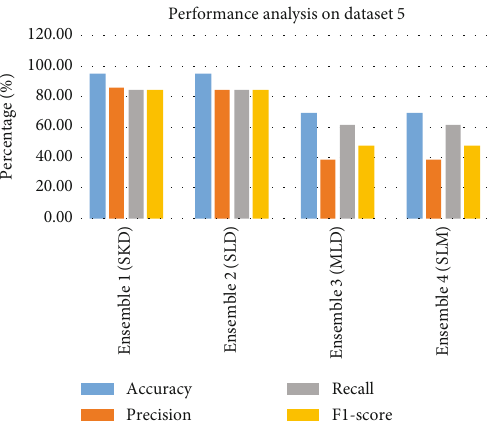
Figure 10: Performance analysis on dataset